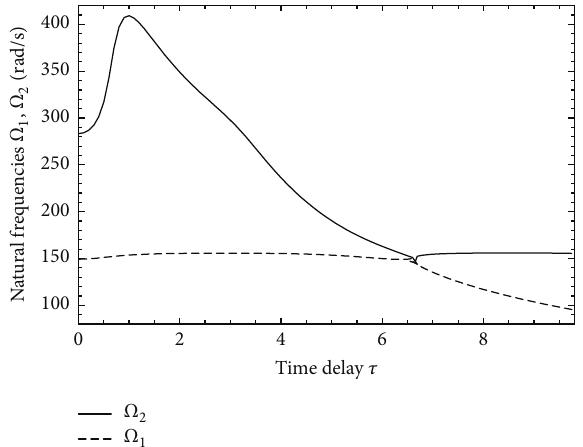
Figure 4: The relationship between the first and second natural frequency.